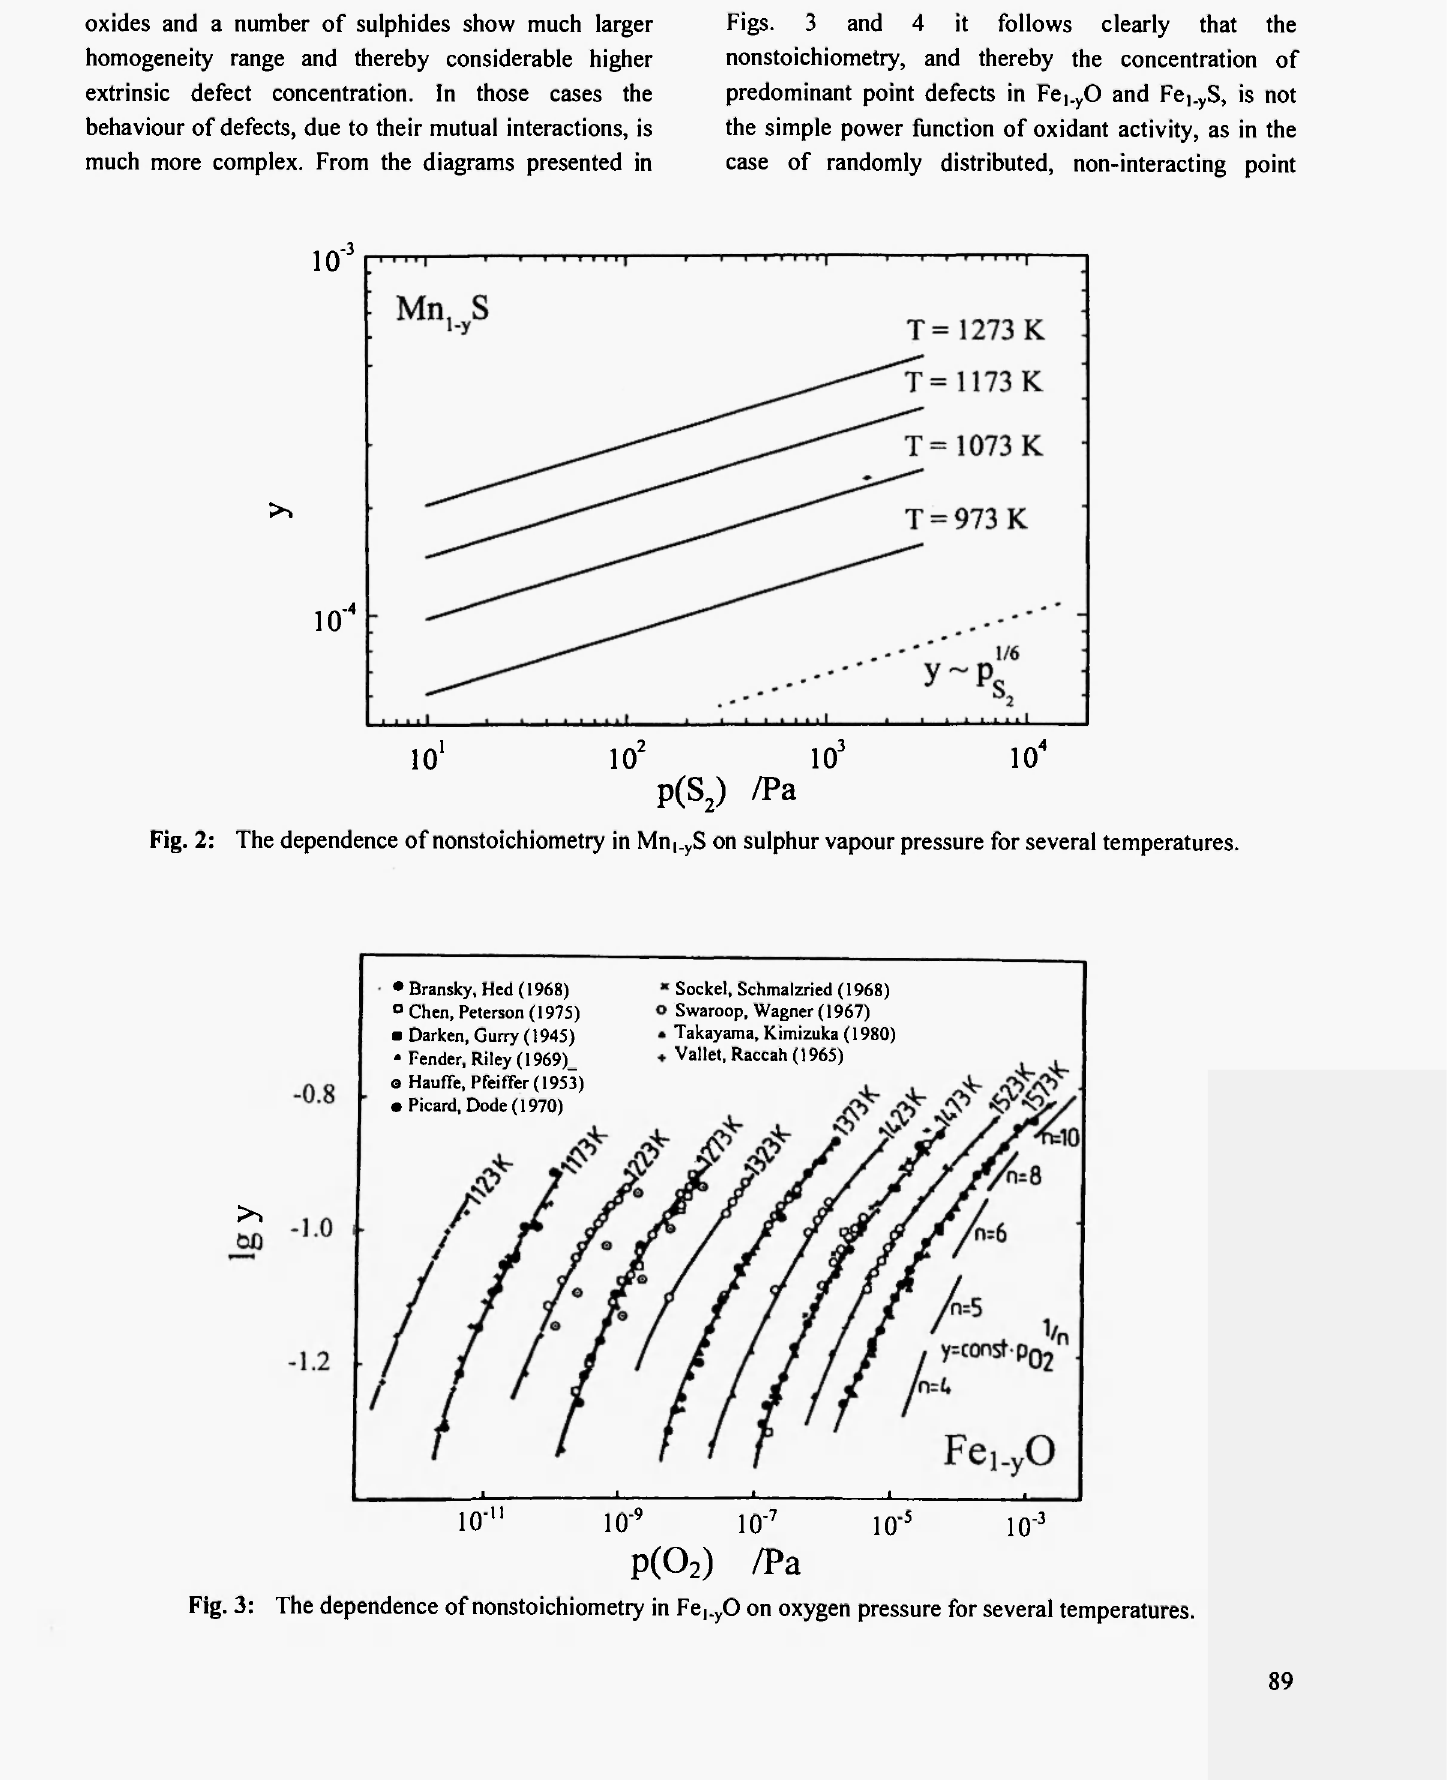
The dependence of nonstoichiometry in Fej. y O on oxygen pressure for several